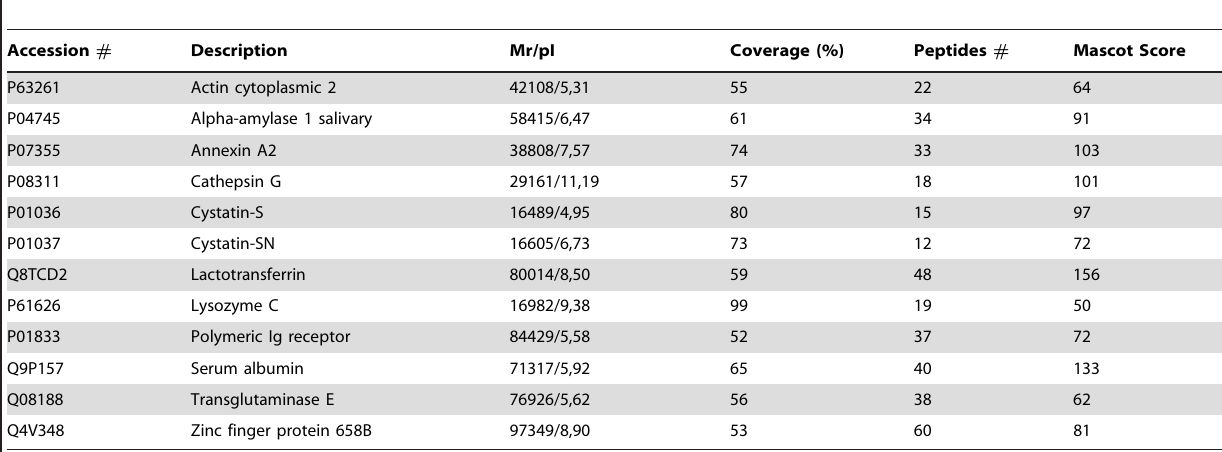
Table 2. Proteins identified by MALDI-TOF MS. Protein theoretical relative mass (Mr) and isoelectric point (pI) are reported along with the coverage percentages, the number of matching peptides and the Mascot identification